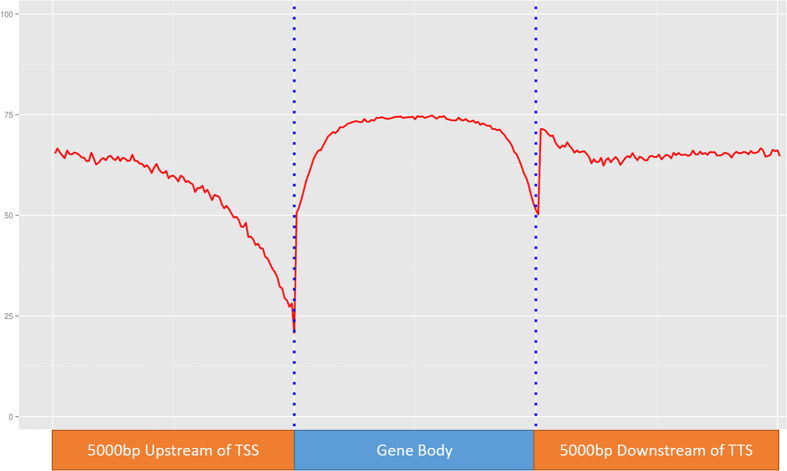
CpG Methylation level in relation to gene body, 5 Kb region upstream of TSS and 5 Kb downstream of TTS in hybrid tilapia.CpG methylation level dropped gradually to 25% approaching the TSS before rising sharply to 75% in the gene body. CpG methylation level then dipped rapidly to 50% approaching the TTS and subsequently returned to earlier intragenic CpG methylation level.